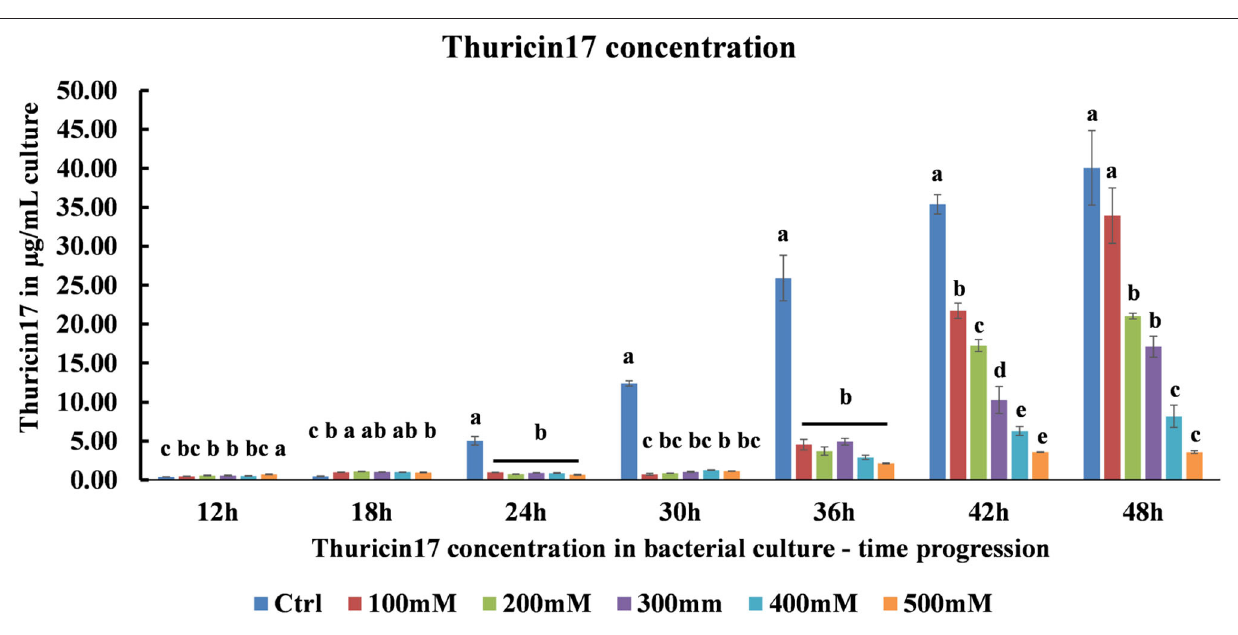
FIGURE 2 | HPLC quantification of thuricin17 under salt stress using pure thuricin17 as standard. The graph represents means and standard error of bacterial culture in 250mL conical flask ( n = 3, where every n = 2 technical replicates per treatment in every experiment).